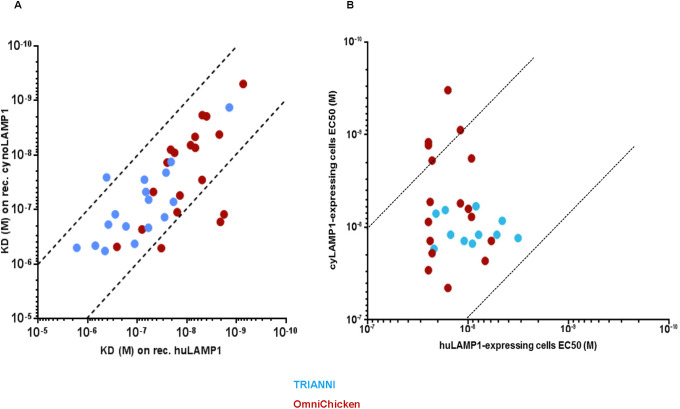
Majority of selected mAbs are cross-reactive with human and cynomolgus LAMP1.Binding of anti-LAMP1 antibodies to recombinant human and cynomolgus LAMP1 as measured by SPR (A) and to cell-surface expressed human and cynomolgus LAMP1 as measured by FACS (B). OmniChicken- and TRIANNI-derived mAbs are represented as brown and blue circles, respectively. Dotted lines indicate KD ratios (human/cynomolgus) of 0.1 and 10.